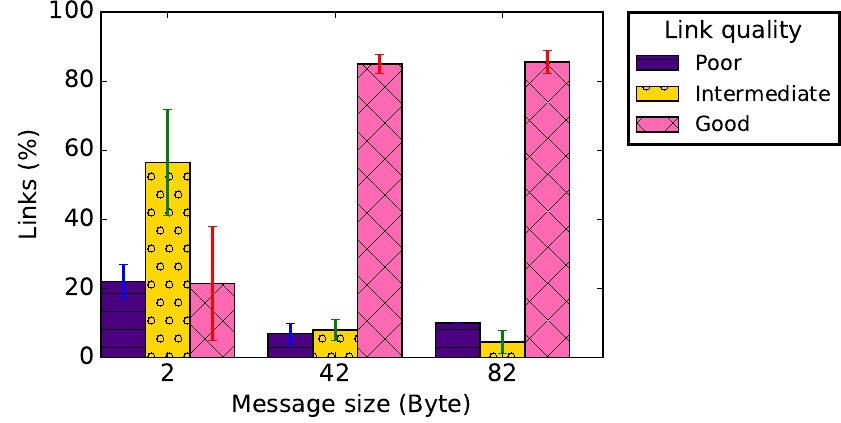
Figure 9. Link quality classification for different packet sizes. Table 2. Link asymmetry for different packet sizes. 2